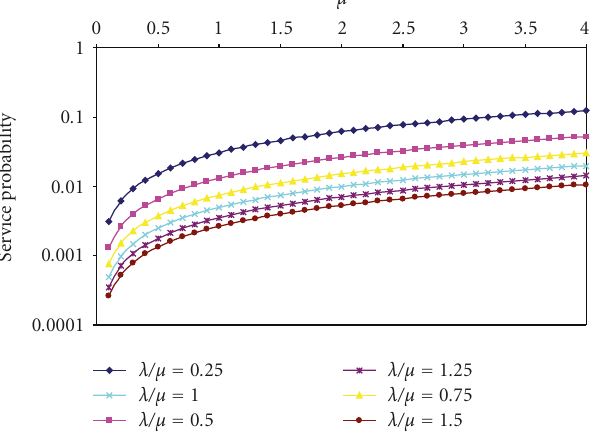
Figure 3: Service probability in the spontaneous